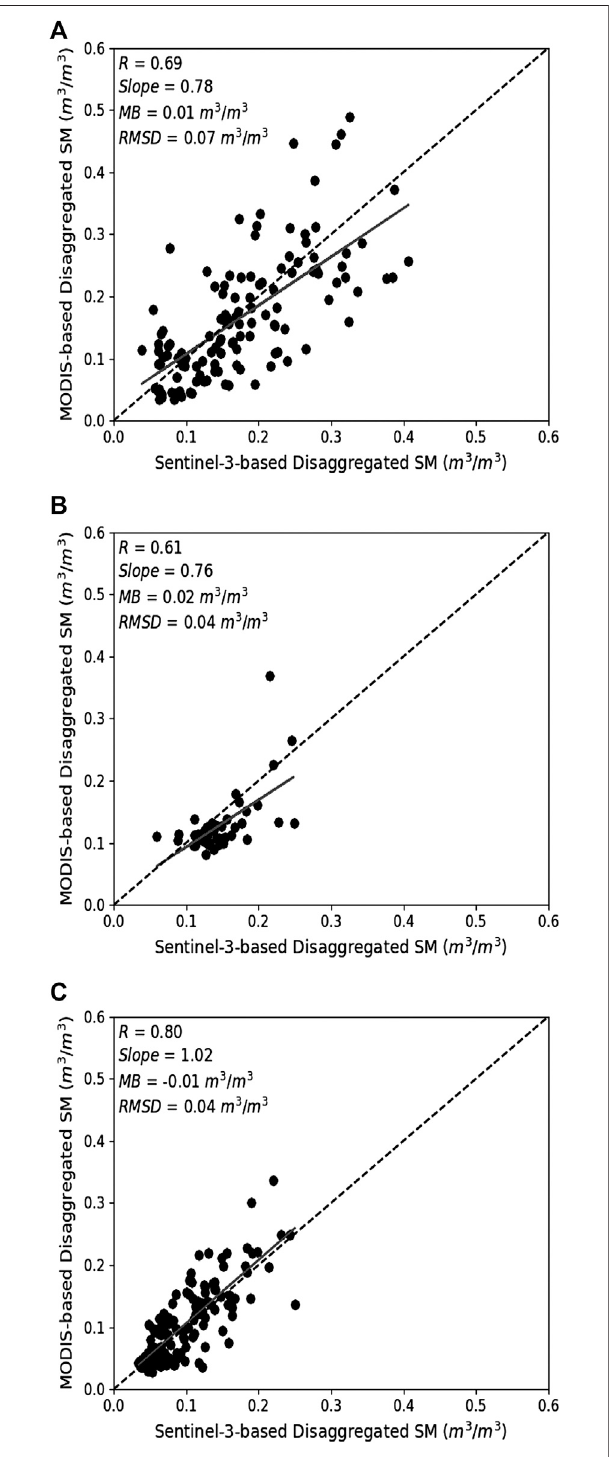
FIGURE 6 | Scatterplot between Sentinel-3 and MODIS-based 1 km resolution disaggregated SM at Auradé (ICOS) site, 2018 (A) ; BA (dryland) site, 2019 (B) and L03 (REMEDHUS) site, 2017 (C) .